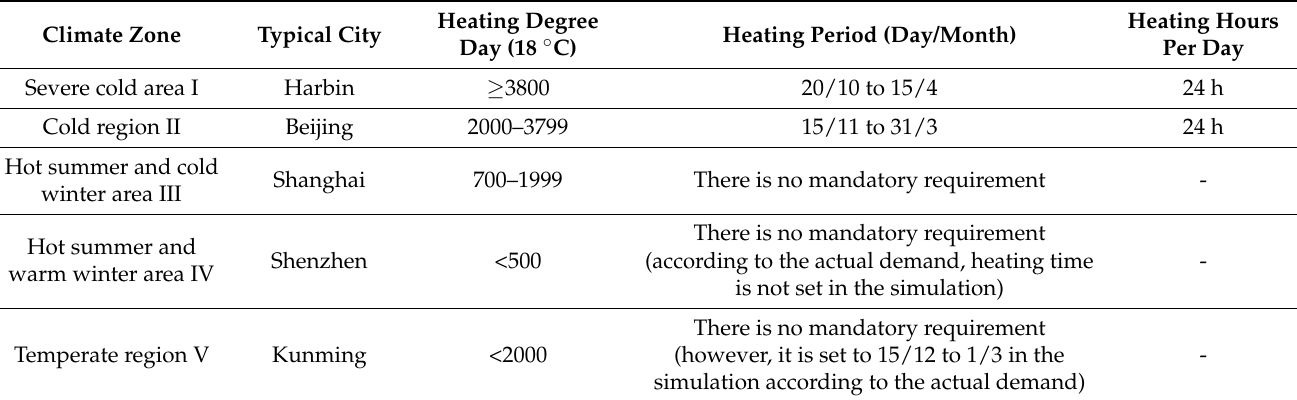
Figure 7. Zoning map of building climate zones in China. Table 3. Typical cities selected according to building climate